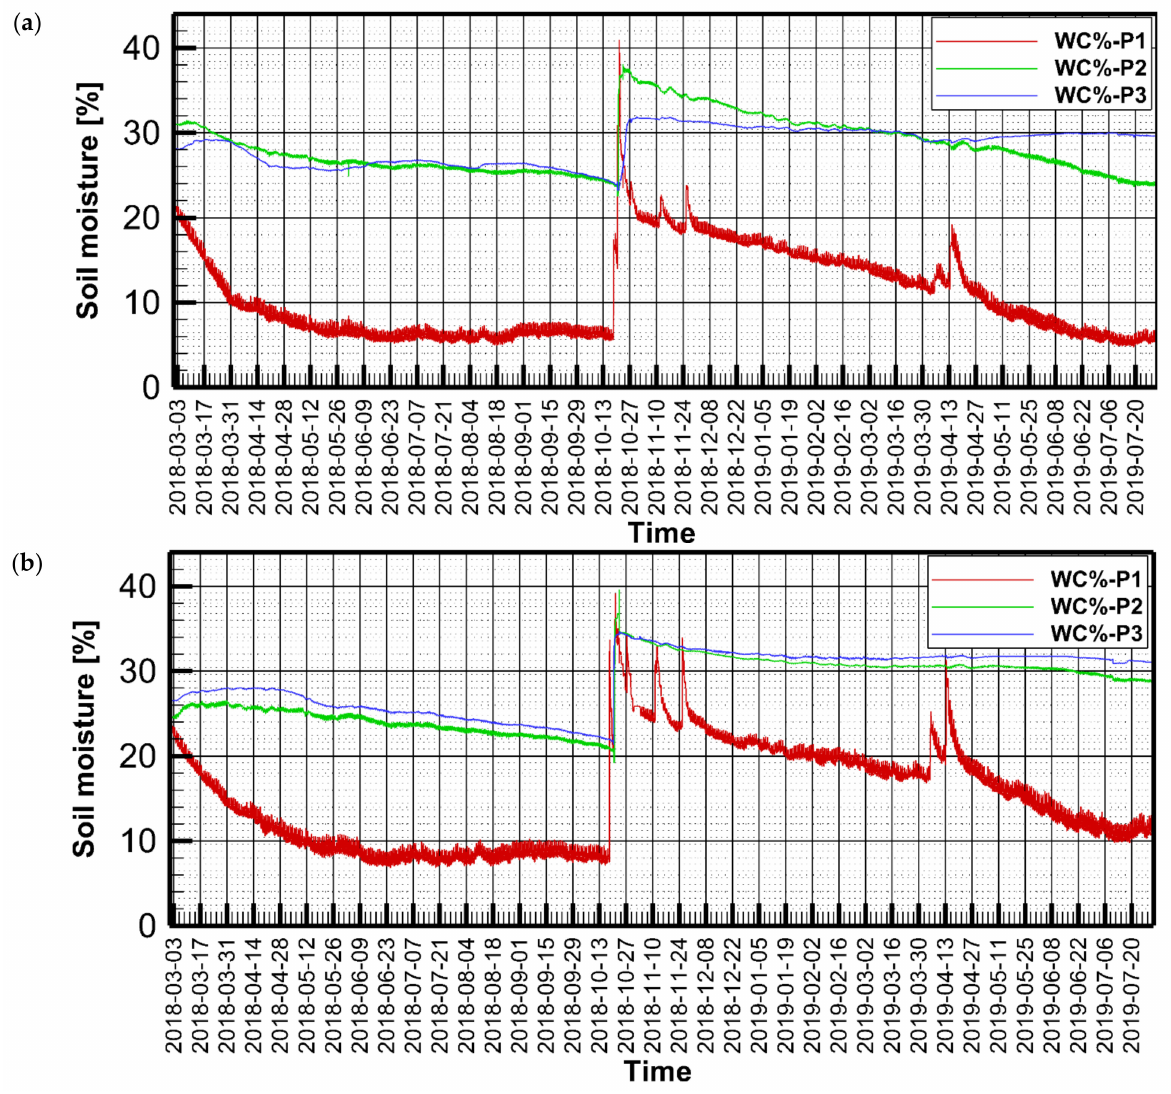
Figure 5. Soil moisture time series for lysimeter 1 ( a ) and lysimeter 2 ( b ). Soil moisture varied between 6% and 35%. While the moisture content at the upper probe showed high variability due to proximity to the land surface, the lower ones